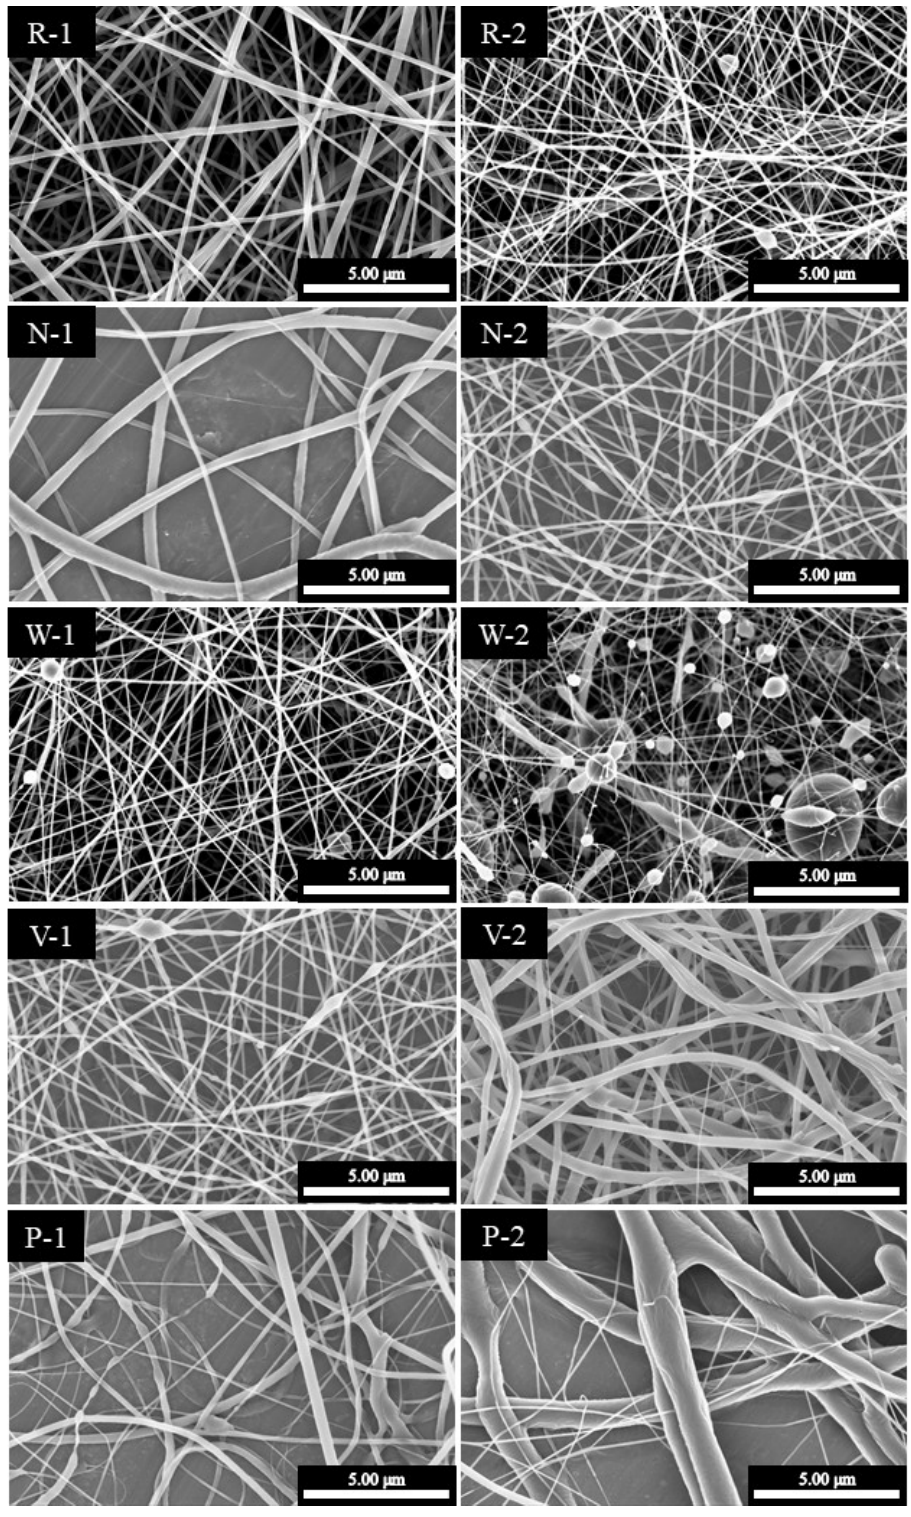
Figure 4. SEM images of the IMQ-PCL nanofibrous meshes. The parameters employed to prepare each sample (R-1 to P-2) are outlined in Table 1.